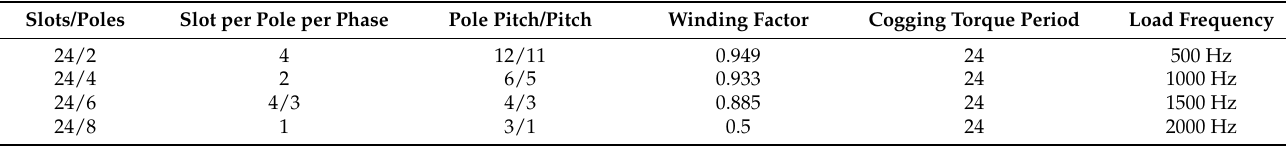
Table 3. Electromagnetic performance comparative analysis under different slots/poles combination.